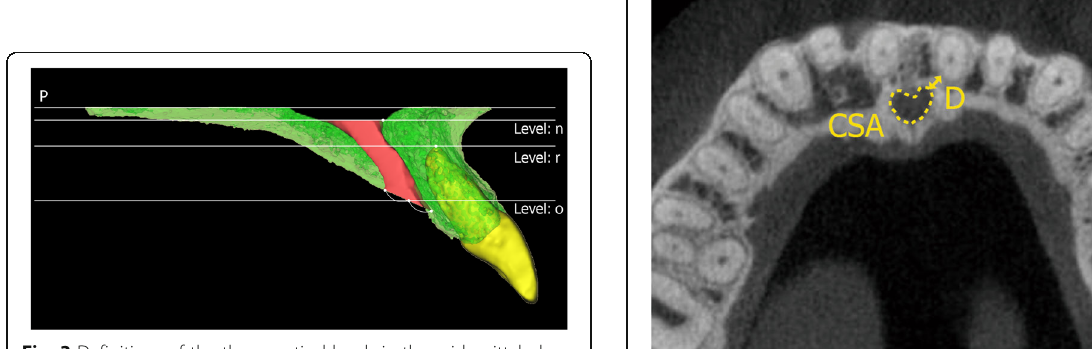
Fig. 3 Definitions of the three vertical levels in the midsagittal plane. n, r, and o, levels of the nasal opening of the incisive canal, root apex of the maxillary incisor, and oral opening of the incisive canal, respectively. P palatal plane